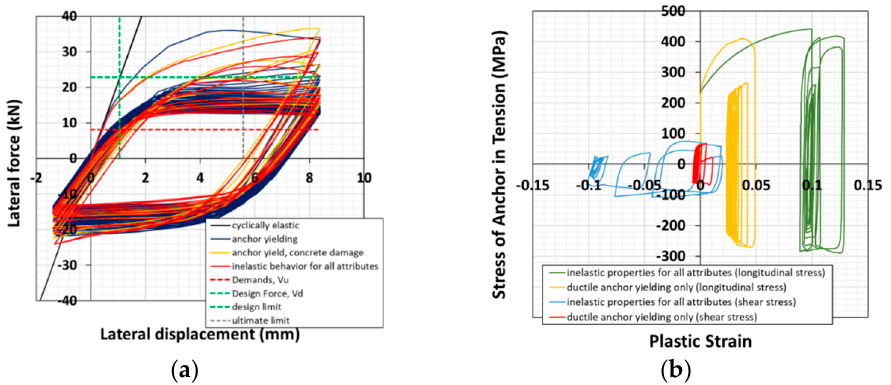
Figure 13. Cyclic pushover simulations ( a ) for different failure mechanisms. ( b ) Normal and shear stresses vs. plastic strain.